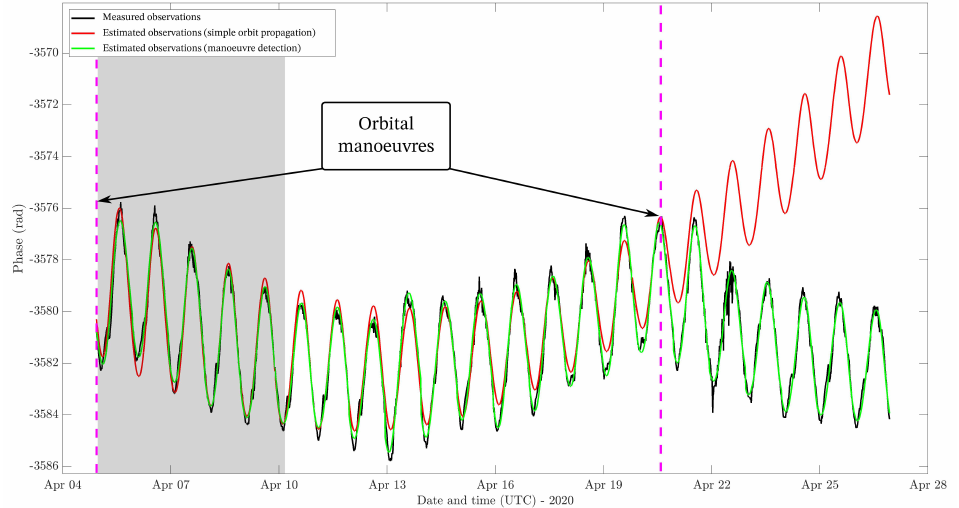
Figure 7. Comparison between the experimental and modeled phase observations. The fitting provides a reference in order to assess whether the interferometric measurements are reliable and consistent. One third of the observation window between orbital maneuvers (shaded area) is used in order to retrieve the orbital state at t 0 . The model fits the experimental data within an orbital maintenance window. The model does not consider artificial forces and, therefore, diverges from the actual motion of the spacecraft when a station-keeping maneuver is performed (simple orbit determination). The continuous observation of the interferometric signals allows the procedure to use updated data in order to keep track of the satellite even after station-keeping maneuvers (maneuver